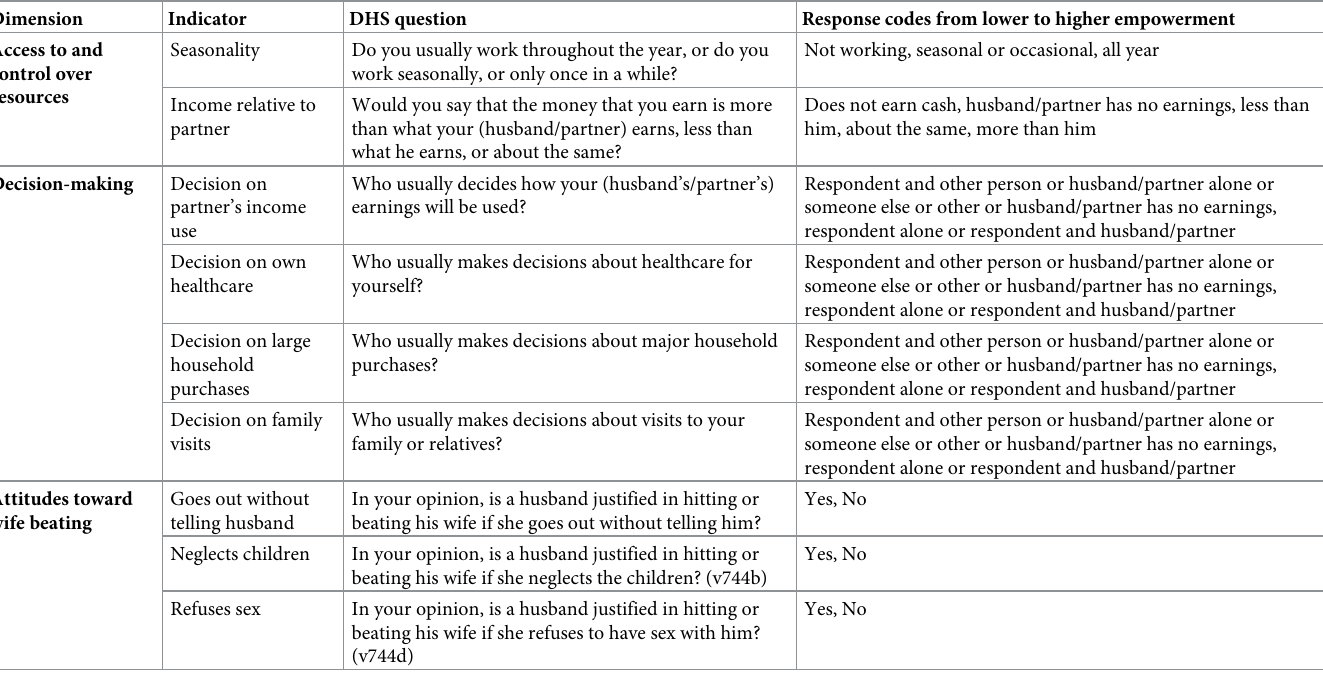
Table 1. Indicators comprising the latent dimensions of the form-invariant women’s empowerment measure.